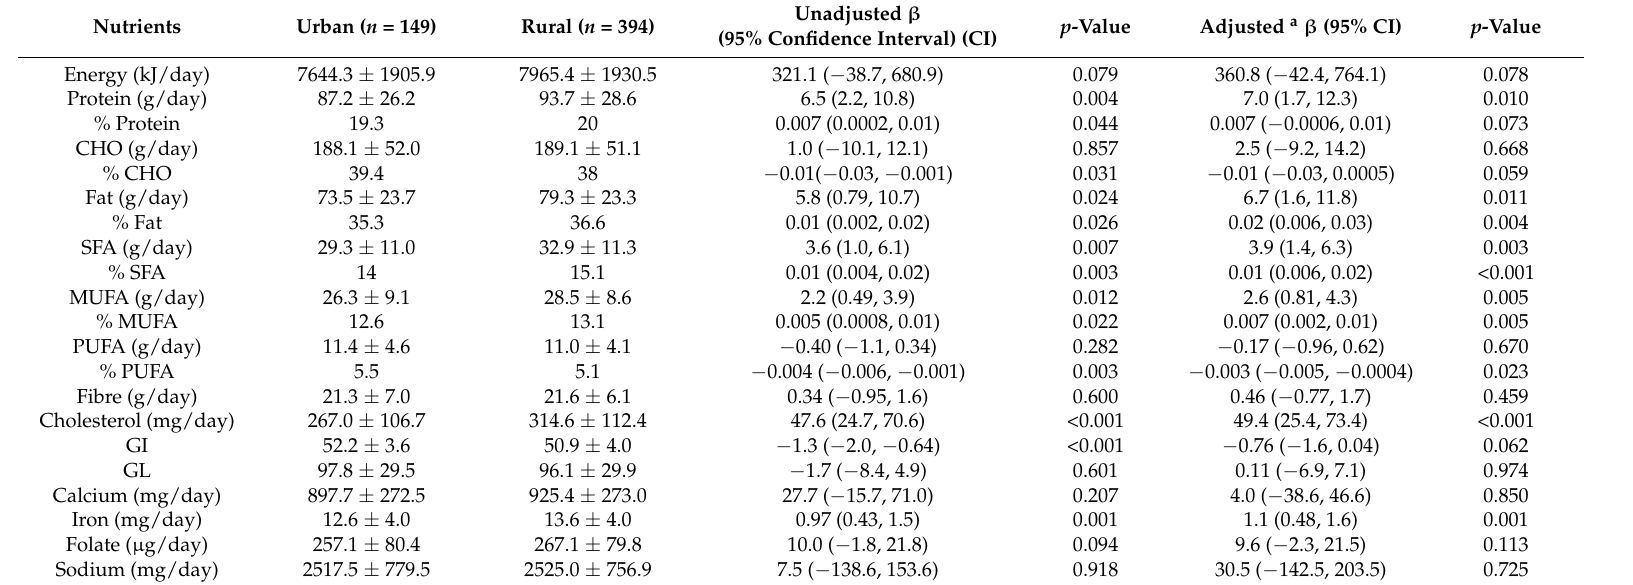
Table 3. Energy, macronutrient and micronutrient intake for urban and rural